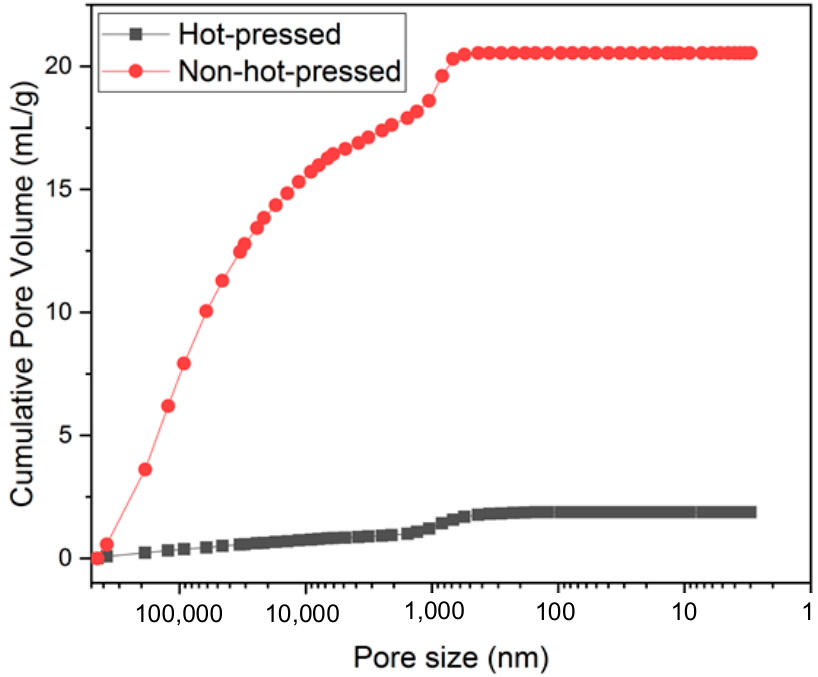
Figure 6. Cumulative pore volume distribution of films before and after hot pressing by mercury porosimetry.